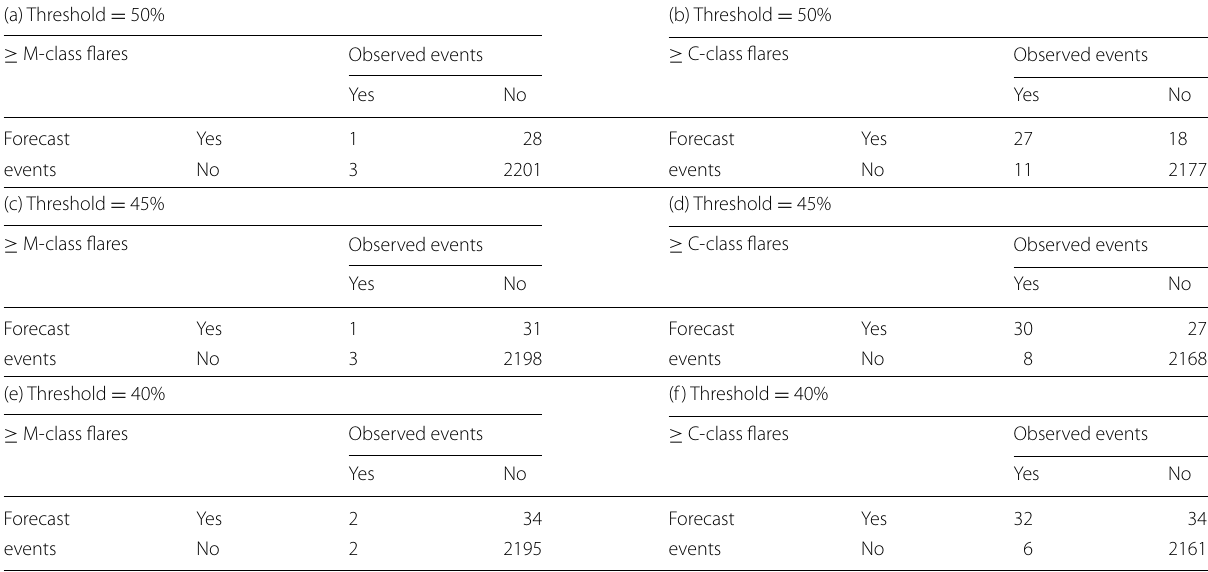
The contingency tables show the forecast results for